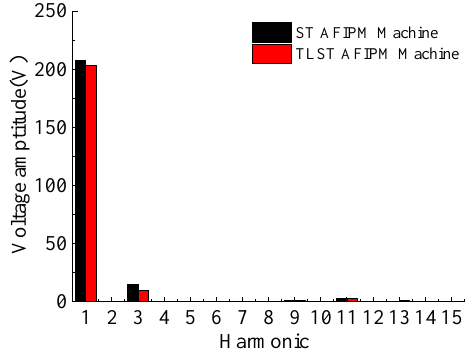
Figure 15. Back electromotive force (EMF) waveforms of the two machines.